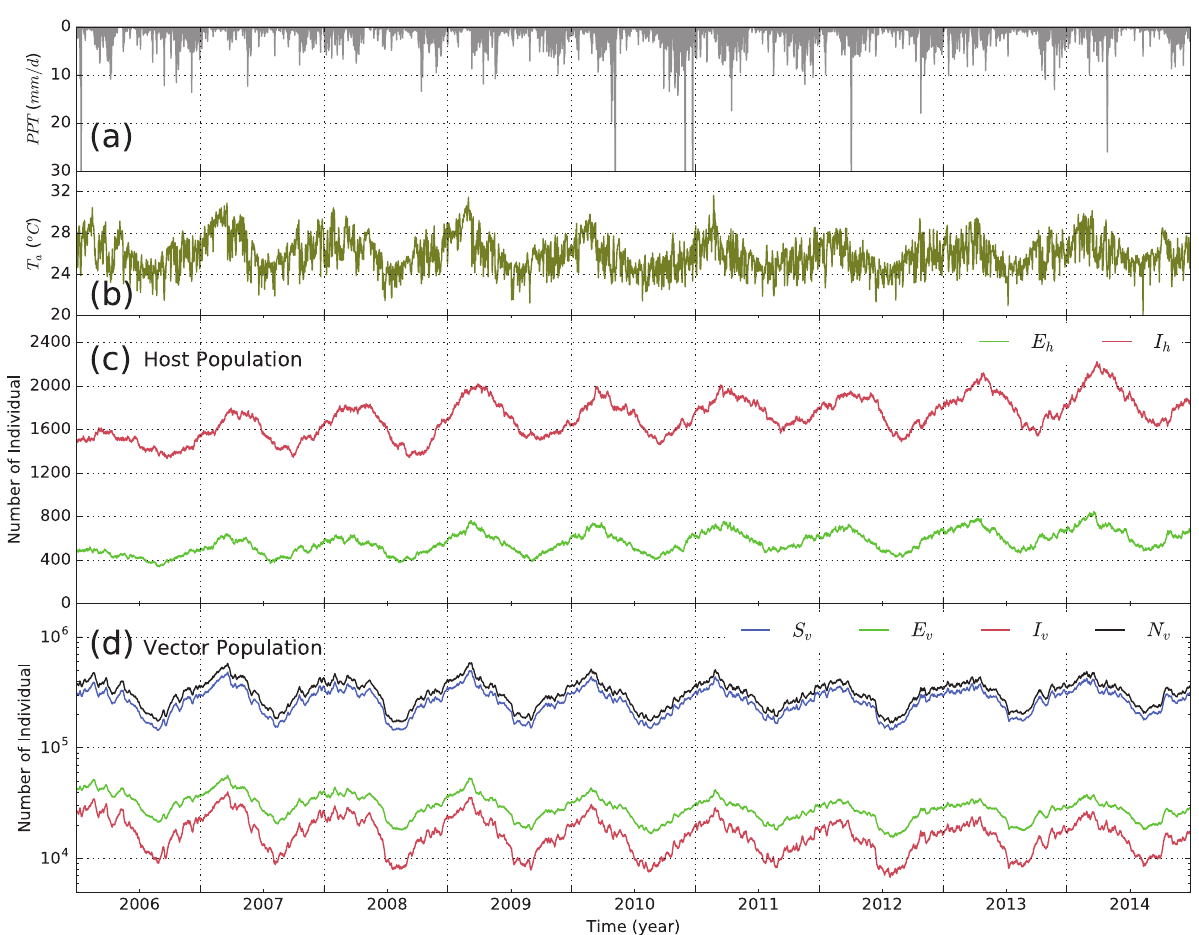
Fig 8. Key meteorological forcing data and the variations of malaria in scenario S0. (a) Daily precipitation and (b) Mean daily air temperature (both are the same as in Fig 6); (c) Variation of exposed ( E ) and infectious ( I ) host populations modeled in the S-SEIR model; and (d) Variation of vector h h populations (susceptible S v , exposed E v , and infectious I v ) modeled in the S-SEIR model. N v represents the total adult vectors. The S-SEIR represents different states of adult vectors shown in S-ELPAs.